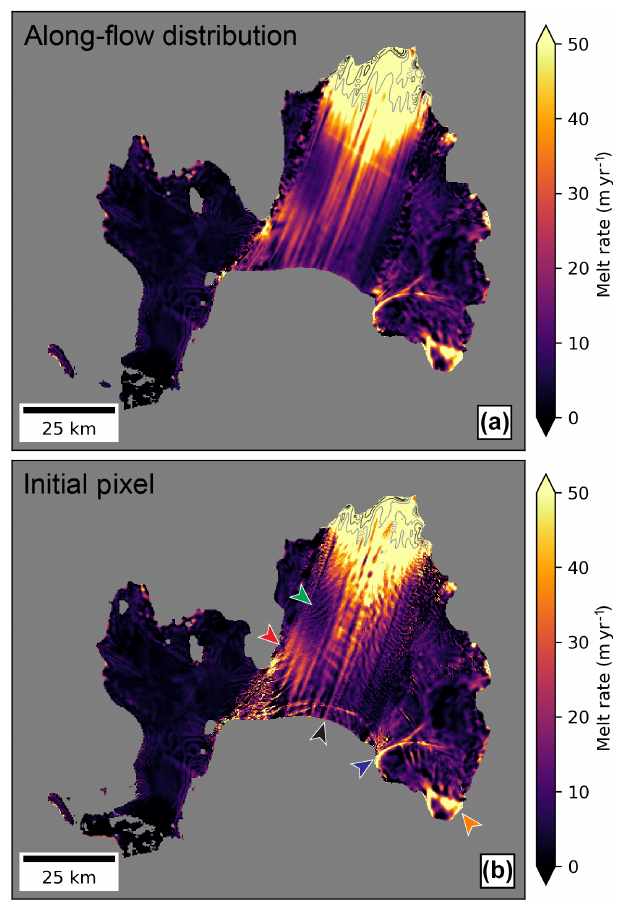
Figure 9. Comparison of mean 2008–2015 basal melt-rate com- posites using: (a) 2-year “along-flow distribution” and (b) 2-year “initial-pixel” methods. Color ramp shows 0–50myr − 1 stretch for basal melt rates, with additional grayscale contours at 100, 150, 200, and 250myr − 1 near the grounding line. The transverse features along the outer ice shelf centerline in (b) are related to enhanced melt within and near depressions or rifts (Shean et al., 2017). The transverse mid-ice-shelf artifact in (a) is the result of a seam artifact in one of the TerraSAR-X velocity mosaics. Colored arrows show features discussed in the